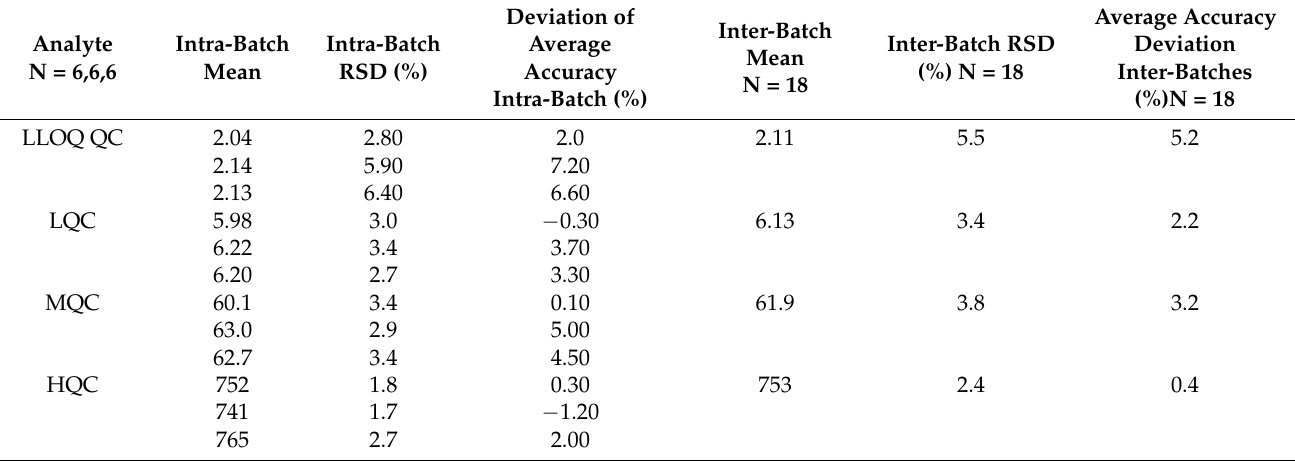
Table 2. Evaluation results for the accuracy and precision for intra-batch and inter-batch sample detection.